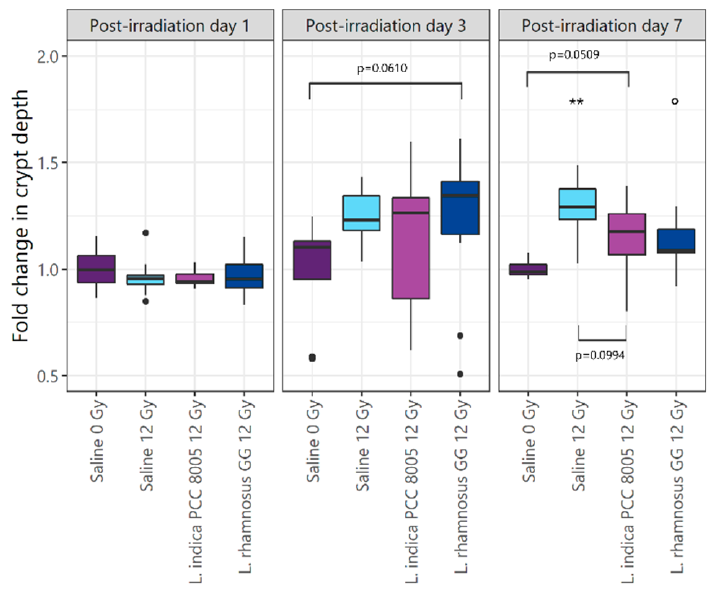
Figure 4. Boxplots showing the fold changes in mucosal crypt depth following pelvic (sham-)irra- diation for all different experimental groups. Outliers are depicted by dots, n = 10 per group, ** p < 0.01 for pelvic irradiation-induced differences in respect to sham-irradiation, and ° p < 0.05 for food supplement-dependent differences in respect to saline administration by linear modelling.